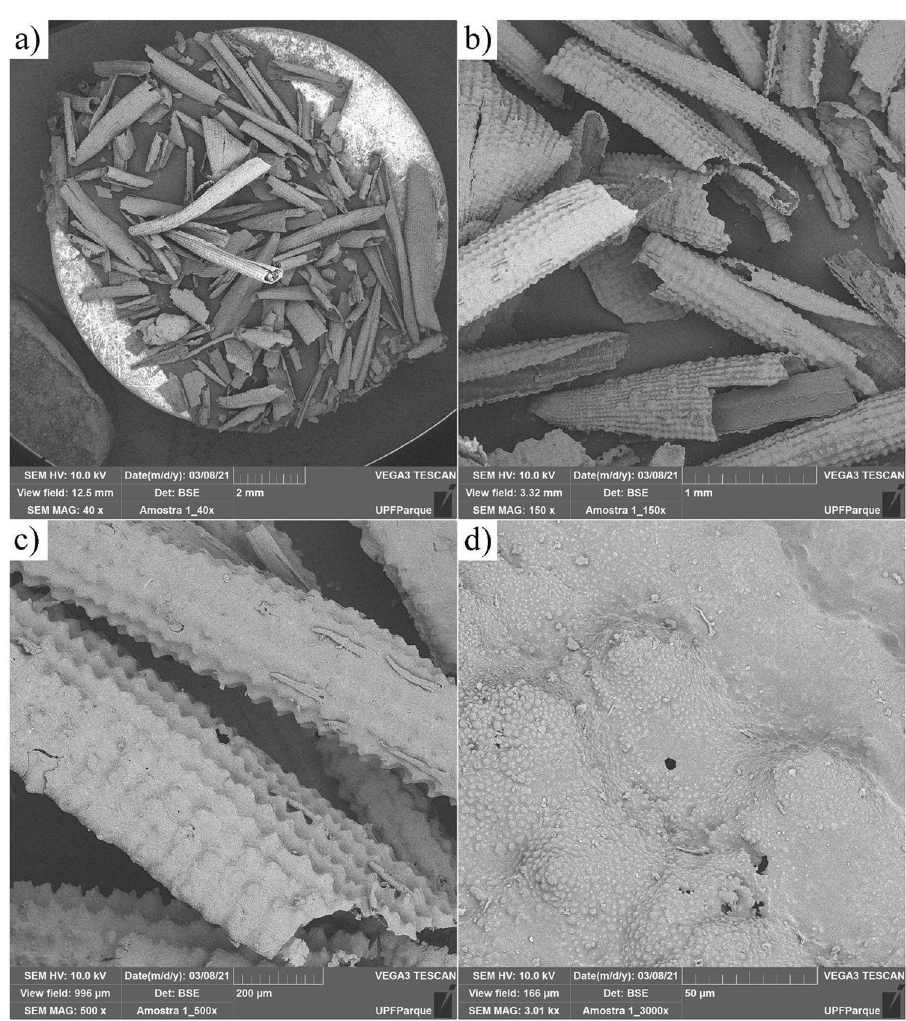
Figure 3. RHA morphology at ×40 ( a ), ×150 ( b ), ×500 ( c ) and ×3000 ( d )